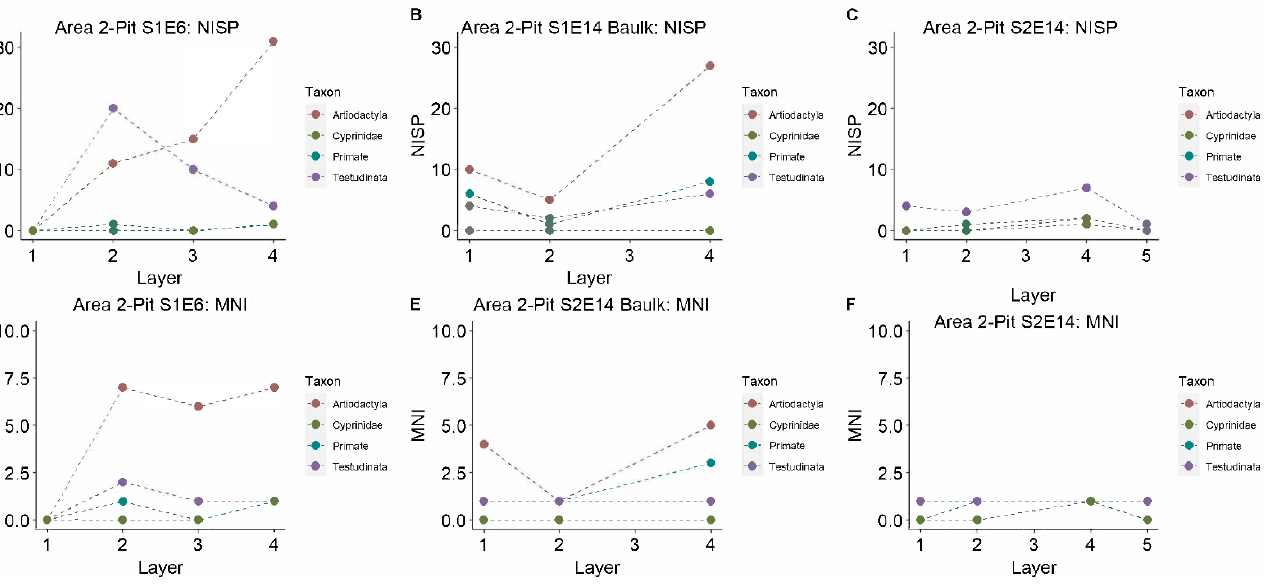
Figure 7. Diachronic change in taxonomic abundance (NISP, number of identified specimens and MNI, minimum number of individuals) within Area 2: ( A , D ) S1E6; ( B , E ) S2E14 Baulk; and ( C , F )